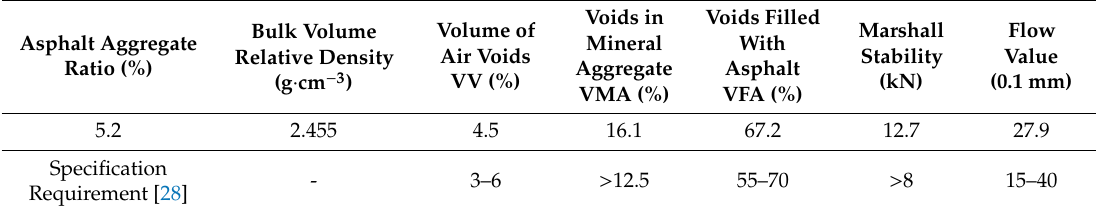
Table 5. Marshall Test results at optimal asphalt content.